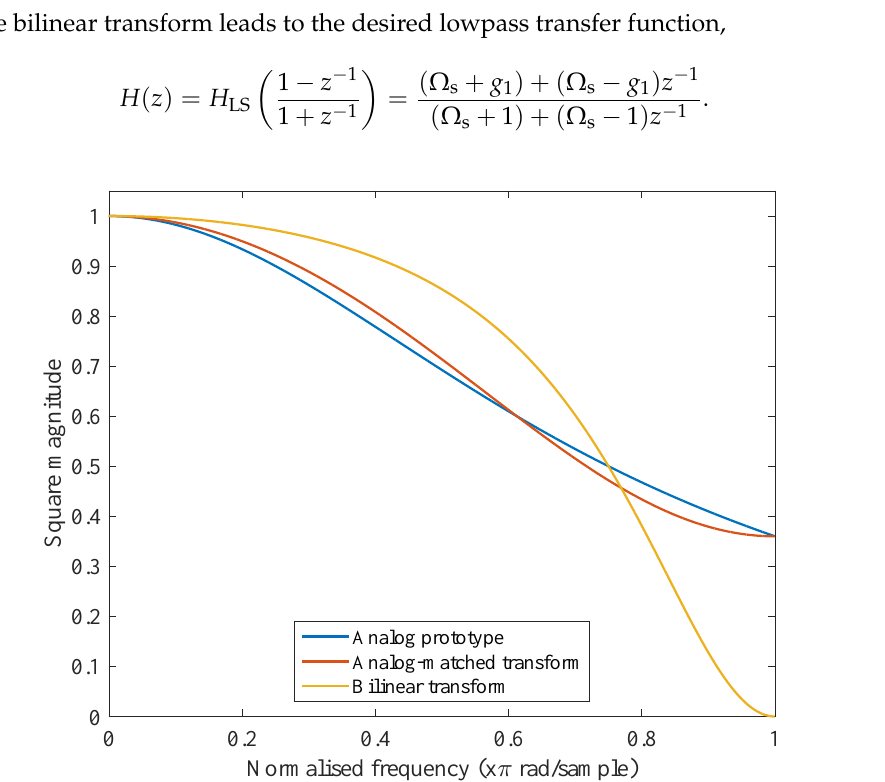
Figure 13. The square magnitude responses of first order lowpass filters with crossover frequency 0.75 π for an analog prototype, an analog-matched digital filter, and a digital filter derived using the bilinear